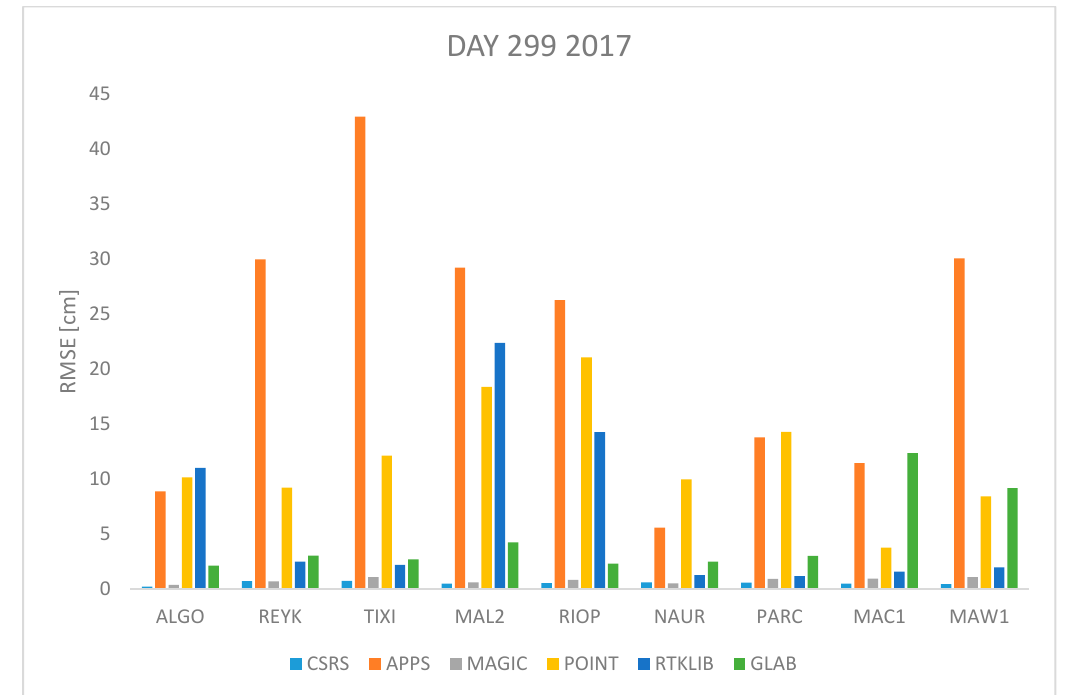
Figure 8. RMSE in centimeters for day 299 in year 2017.